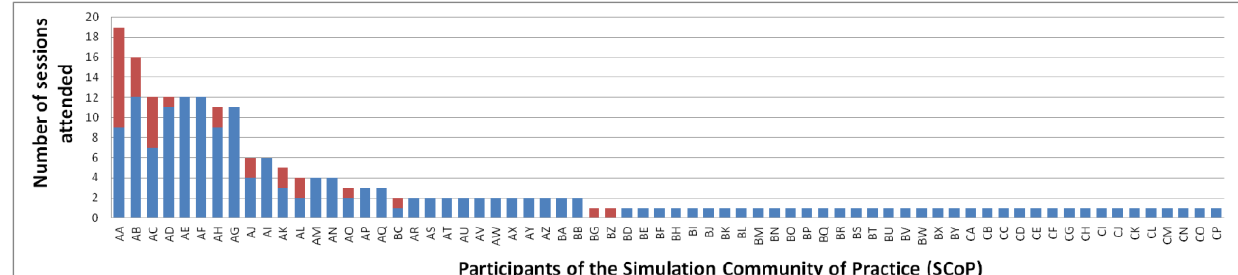
Figure A: 68 people participated in the 20 first sessions of the SCoP. In blue are the number of times each person took part in a session as a participant, and in red as the organizer (or co-organizer) of the